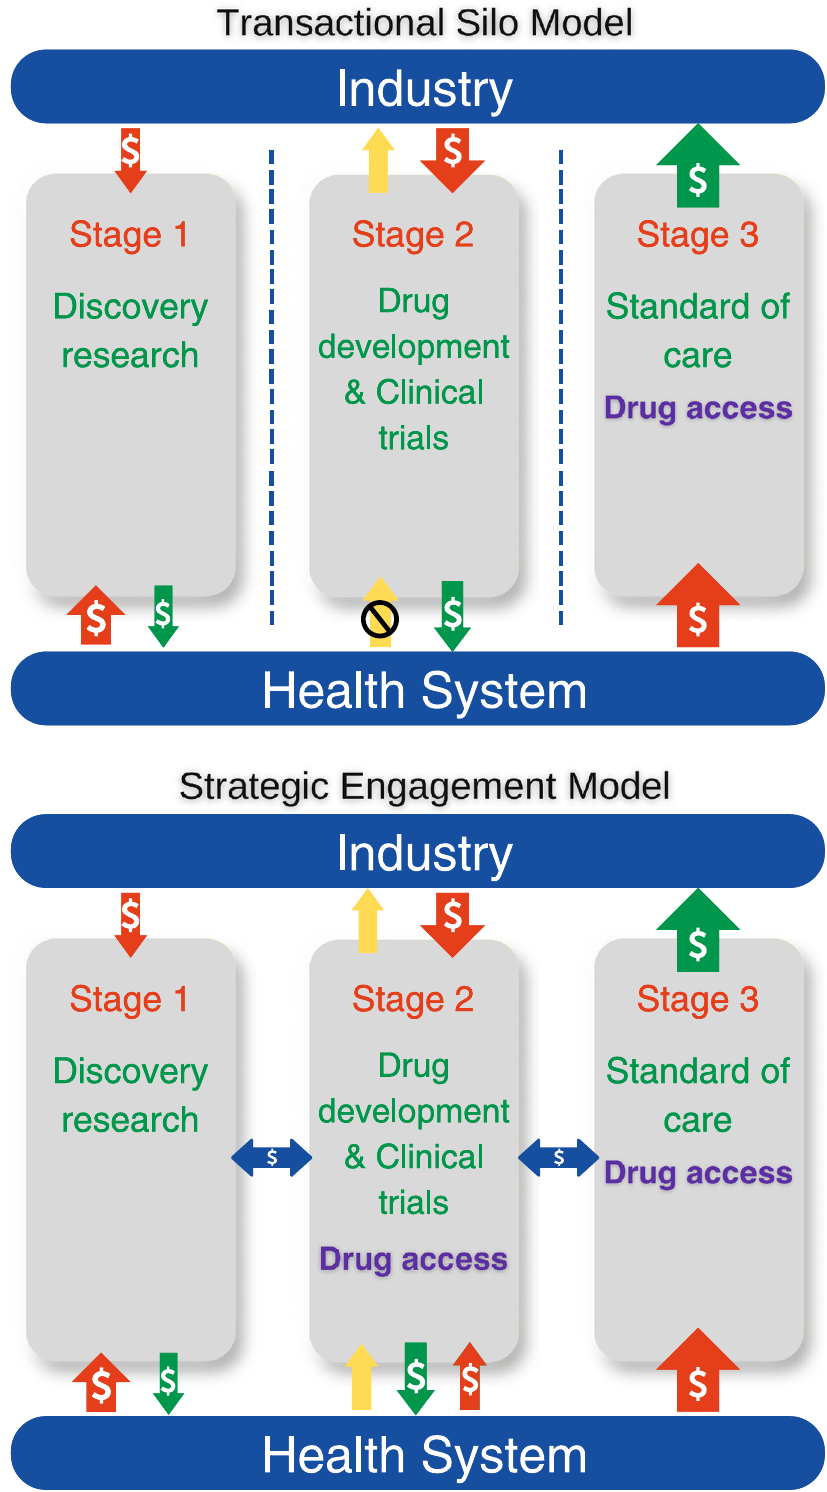
Fig. 1 Three stages of drug development in the existing (transaction silo) model vs. proposed collaborative (strategic engagement) model for improving cost-ef fi ciency and sustainability of innovative health care. Red arrows depict investments; green arrows depict returns; blue arrows indicate exchanges of value; yellow arrows indicate information transfer. Sizes of arrows represent the relative magnitude of monetary value